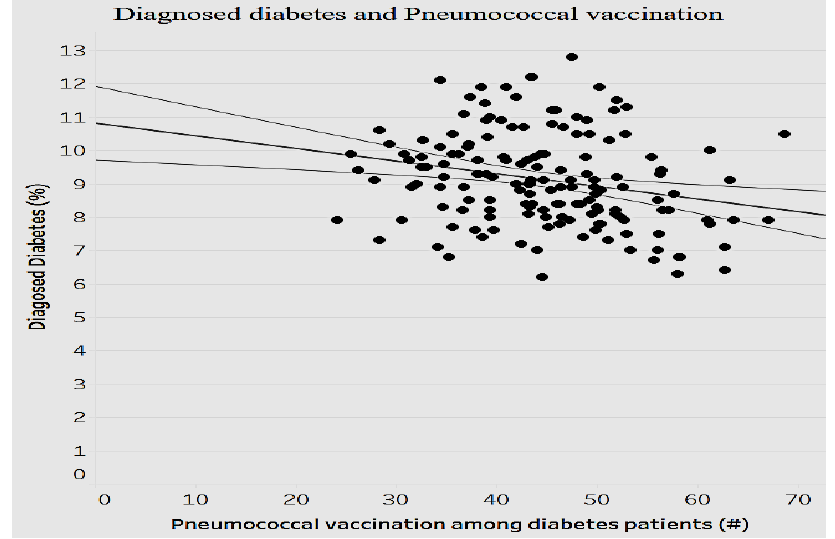
Figure 14. Diagnosed diabetes ratio by pneumococcal vaccination ratio. (#: number).